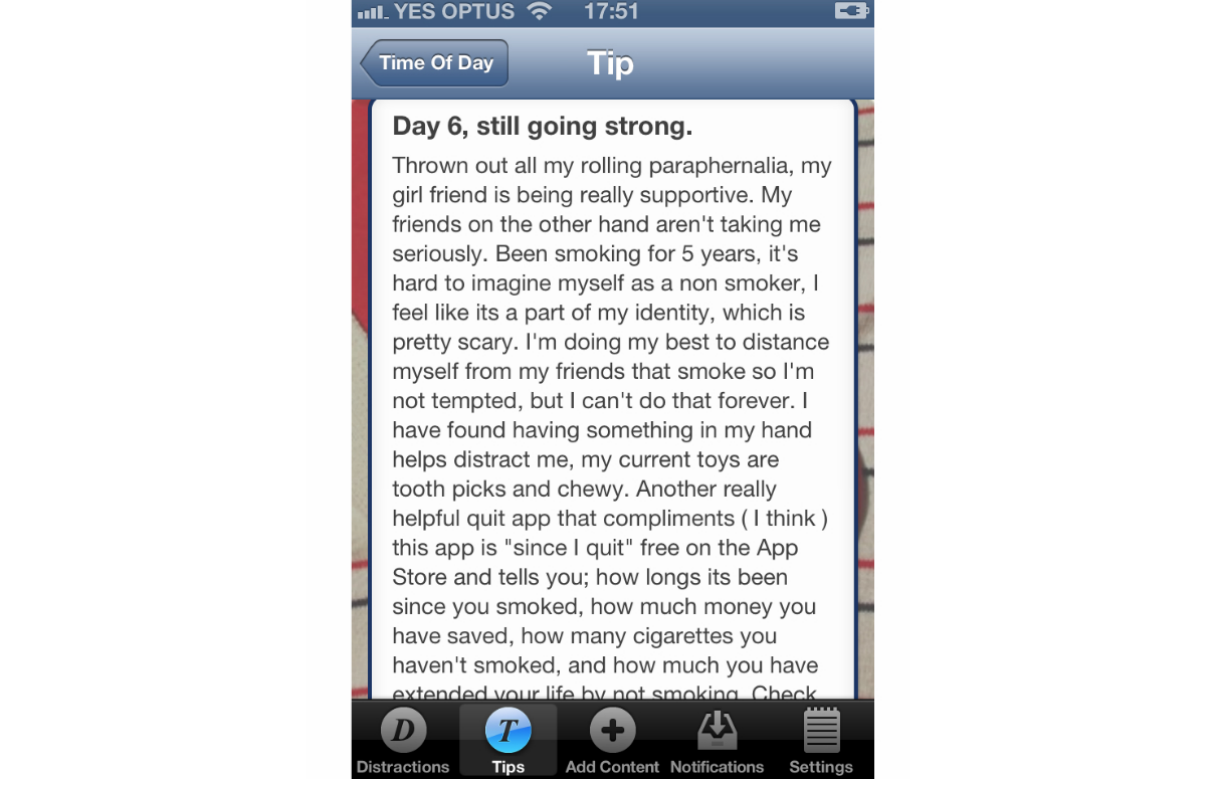
Figure 6. Personal stories written by others who were quitting smoking provided information and reassurance that participants were not alone with their difficulties in